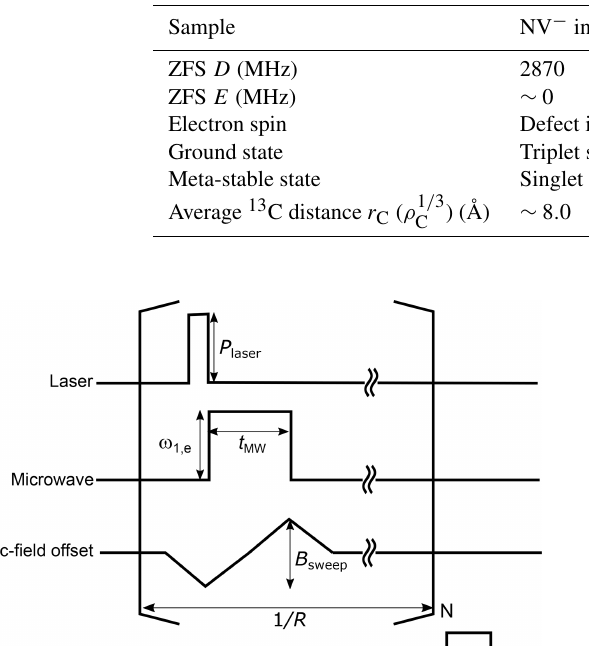
Table 1. Differences between the two samples, NV − in microdiamonds and pentacene in [carboxyl- 13 C] benzoic acid ( α 13 CBA).